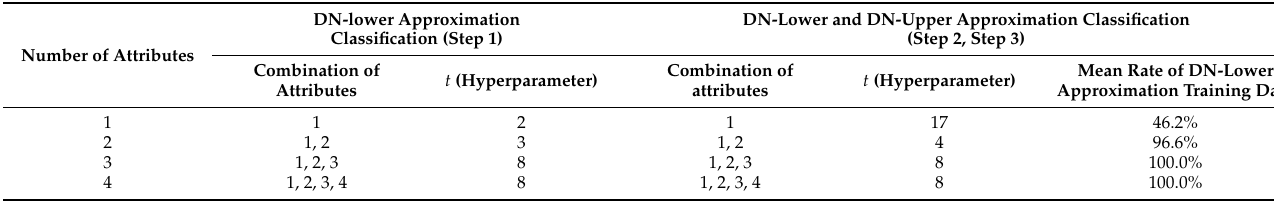
Table 4. Optimal hyperparameters of the DNRS model for Banknote.